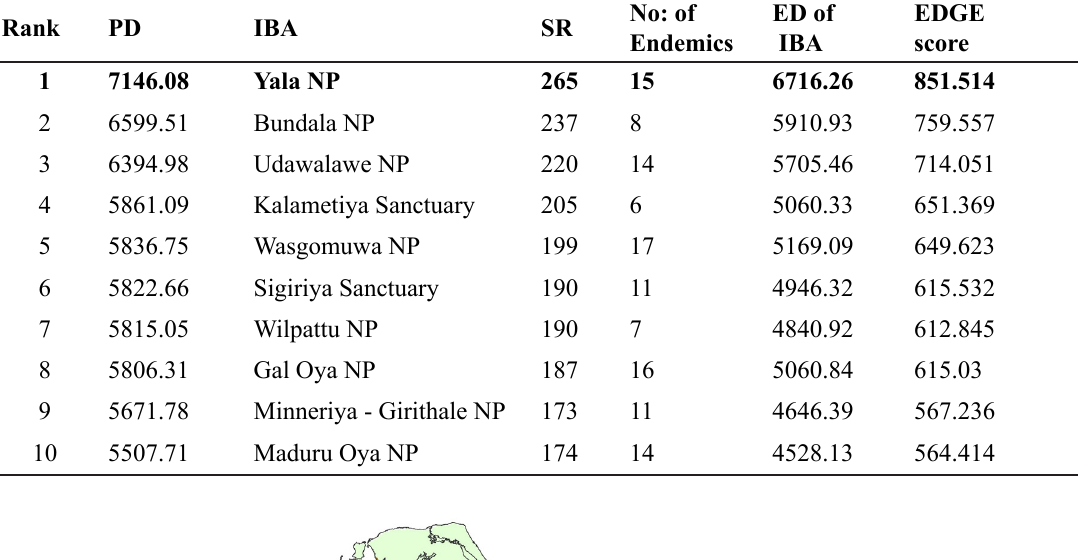
Table 03: Top 10 IBAs with highest phylogenetic diversity (PD). Both resident and migratory species of birds were included for this analysis.